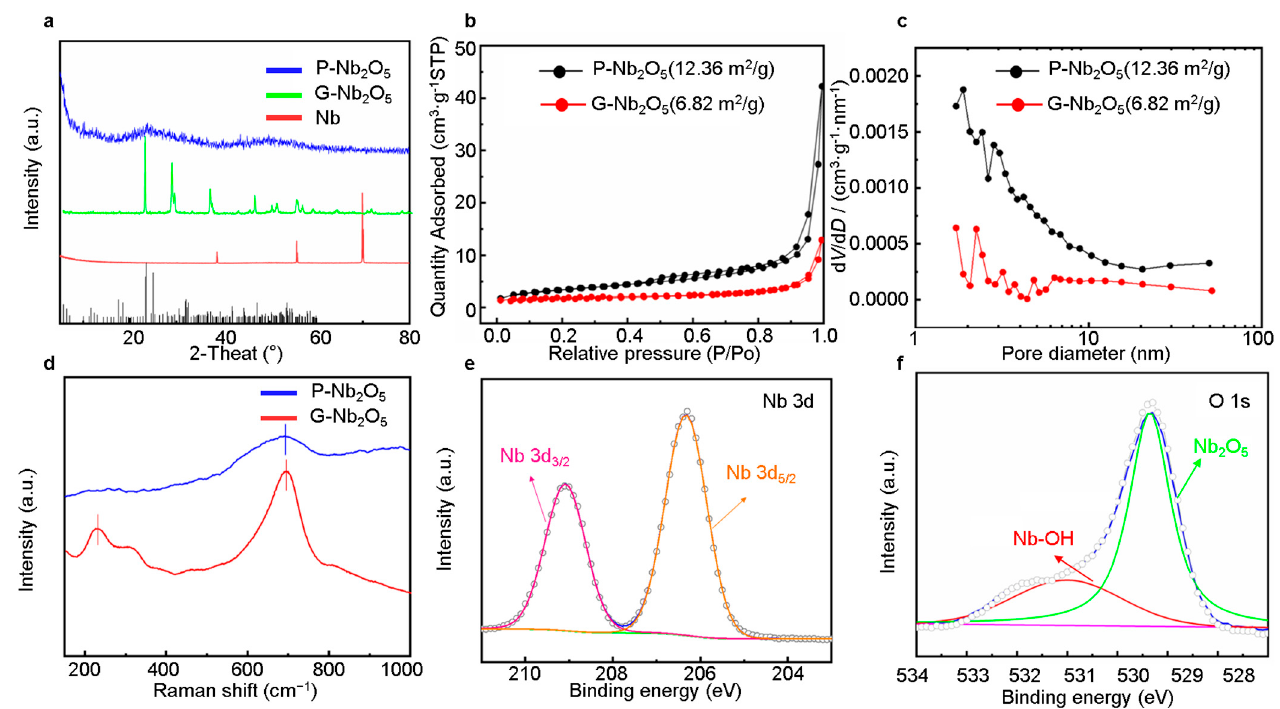
Figure 3. ( a ) XRD patterns; ( b ) adsorption-desorption isotherms of the P-Nb 2 O 5 and particles of P-Nb 2 O 5 ; ( c ) pore size distribution of the P-Nb 2 O 5 and G-Nb 2 O 5 ; ( d ) Raman spectra; ( e , f ) high- resolution XPS spectra of the C1s, O1s, and Nb3d peaks of the anodized niobium samples; ( e ) Nb 3d; and ( f ) O1s.